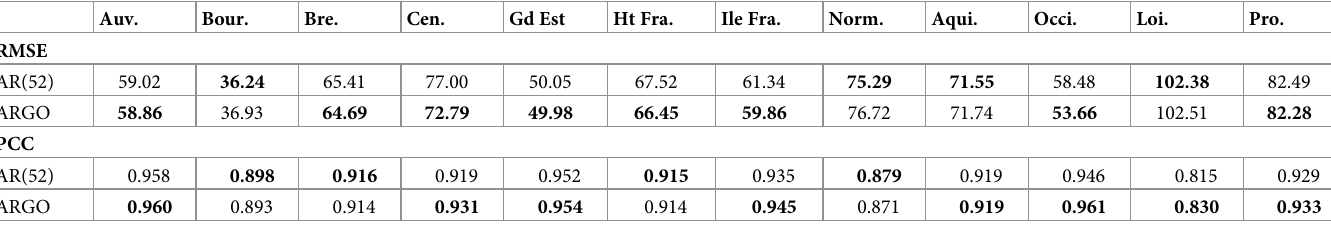
Here, we compare the predictive performance of five different modeling approaches the base- line model, AR(52), ARGO, Net, and ARGONet for three time horizons: real-time, one-week Table 7. Real time estimate—RMSE and PCC for ARGO models including only historical data (AR(52)) and only Twitter data, for the period starting from January 2015 to March 2017. Auv. Bour. Bre. Cen. Gd Est Ht Fra. Ile Fra. Norm. Aqui. Occi. Loi. Pro. RMSE AR(52) 59.02 ARGO